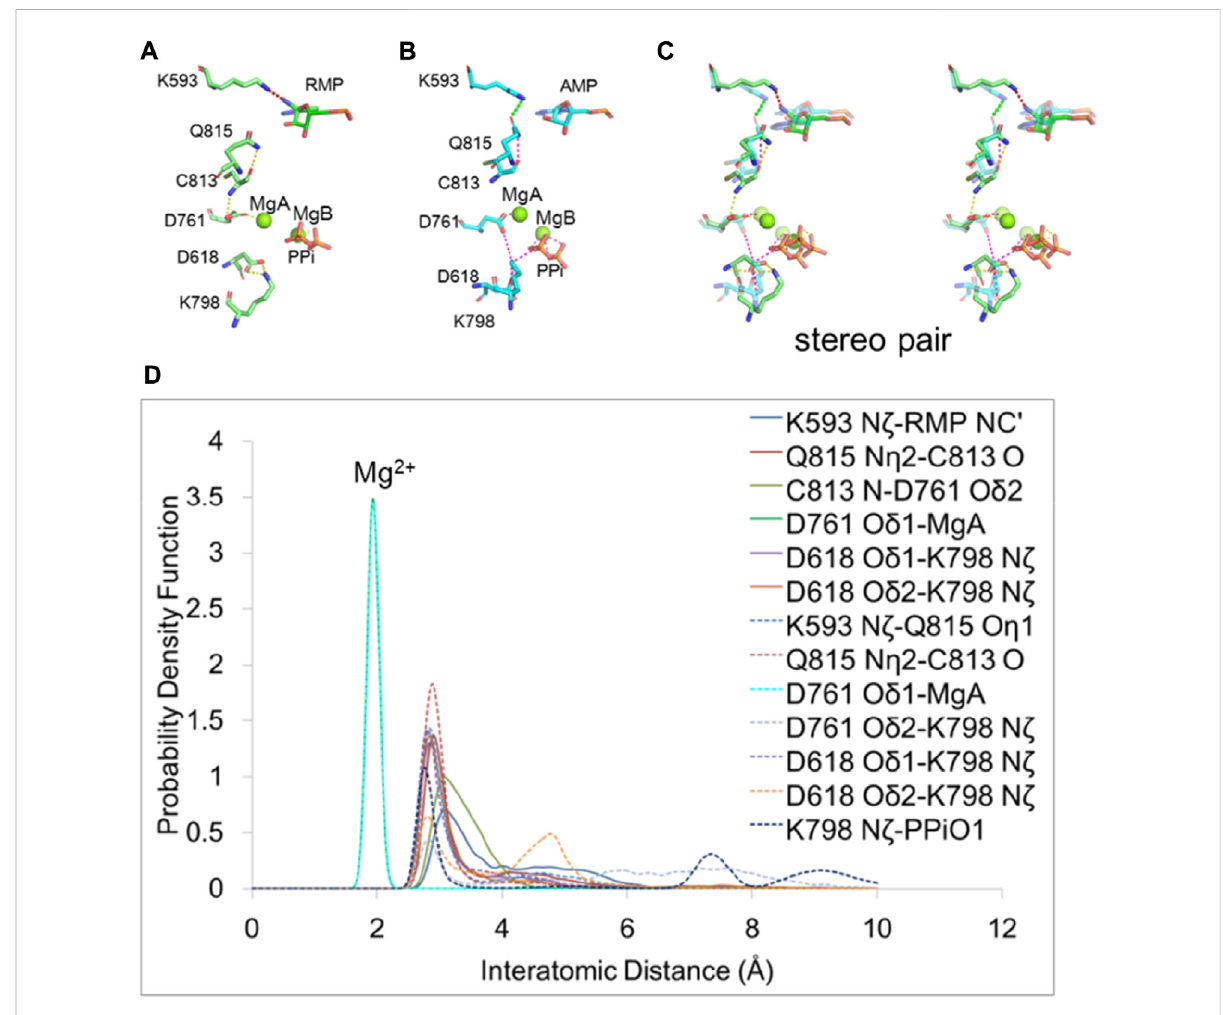
FIGURE 6 H-bondingnetworkforallosterycommunicationbetweenthepolactivesiteandtheremotepositionsofRNAduplex. (A,B) Residuesaffectedby RMP and AMP at position i + 3. H-bond interactions are shown in dash lines. The H-bond between K593 and RMP is shown in red and others are shown in yellow. The H-bond between K593 and Q815 is shown in green and others are shown in magenta. (C) Overlap of RMP (solid curves) and AMP (dashed curves) (transparent) structures in stereodiagram. (D) PDFs of the H-bond distance distribution for interacting residues with RMP and AMP at position i + 3. Peaks that are approximately at 2 Å are for interactions between Mg 2+ and amino acid residues. Others are for interactions between amino acid